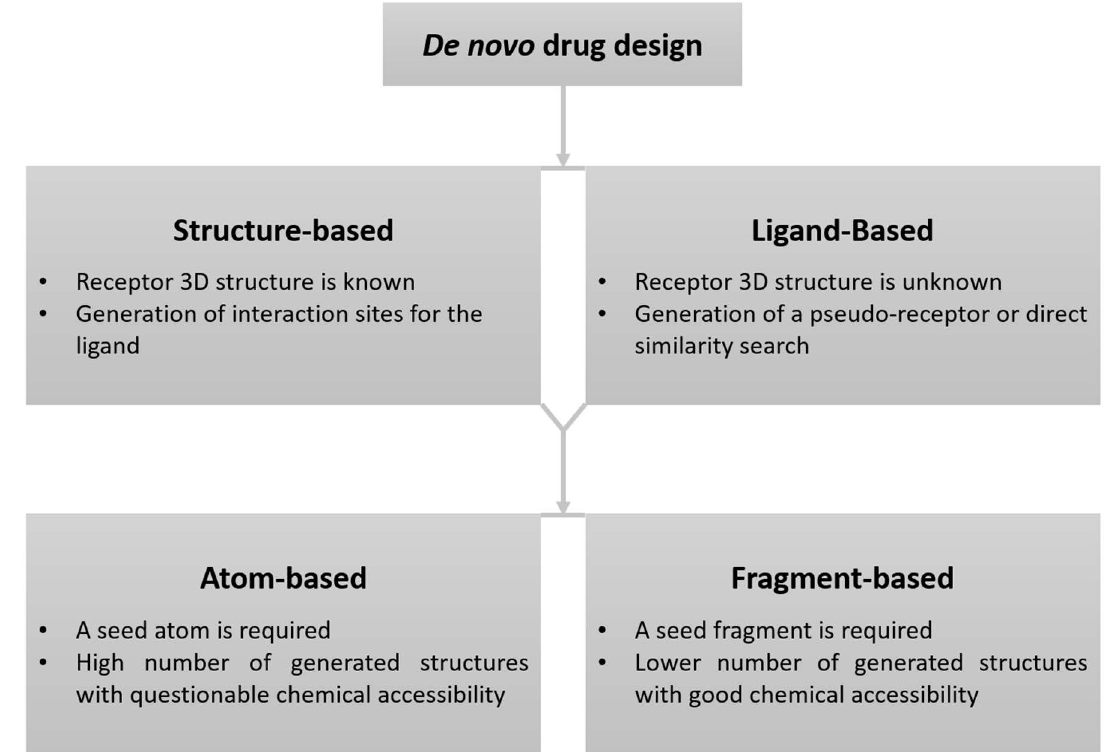
Figure 1. Schematic representation of the de novo drug-design